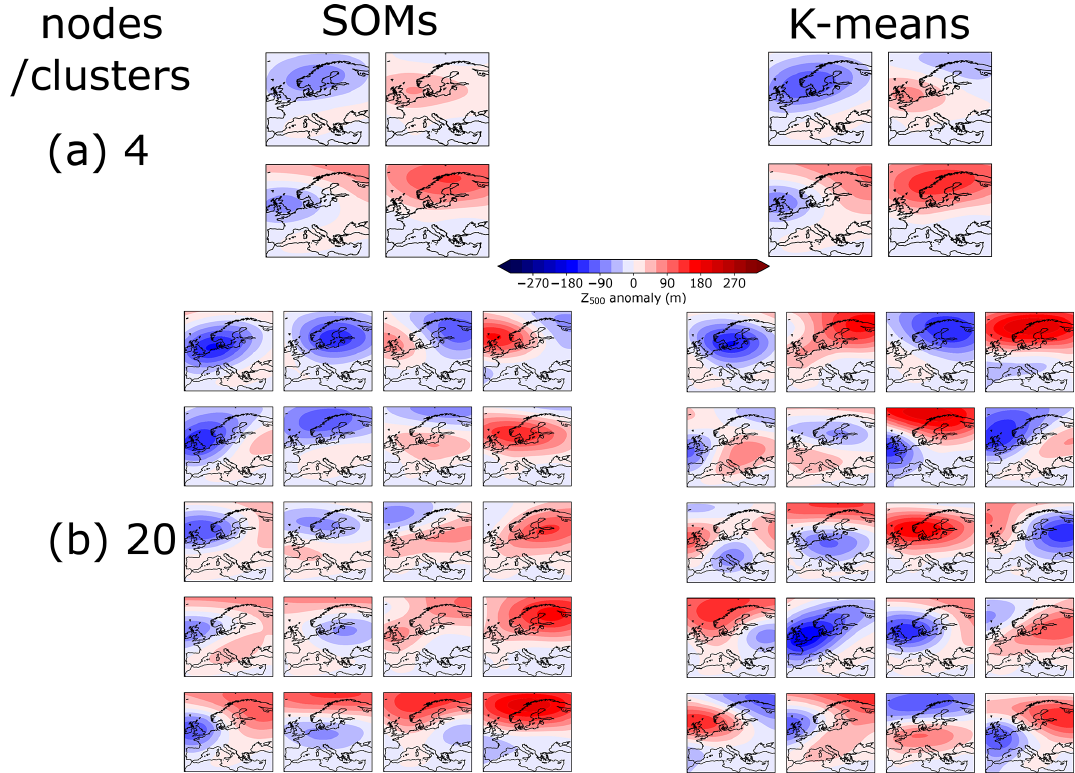
Figure A5. Comparison of the SOM analysis and K -means clustering for (a) 4 and (b) 20 nodes/clusters. Whilst the K -means clustering and SOM analyses produce a similar set of patterns for smaller node numbers, their behaviour diverges for larger node numbers. Since the neighbourhood function ensures that several nodes are updated at once, the SOM produces a continuum of weather patterns. However, since the K -means clustering updates each centroid independently, it will seek to maximize the differences between each cluster. This causes some centroids for high cluster numbers to represent mixed weather regimes that are less realistic than the SOM continuum of weather regimes. The data used for above are ERA5 Z 500 across JJA